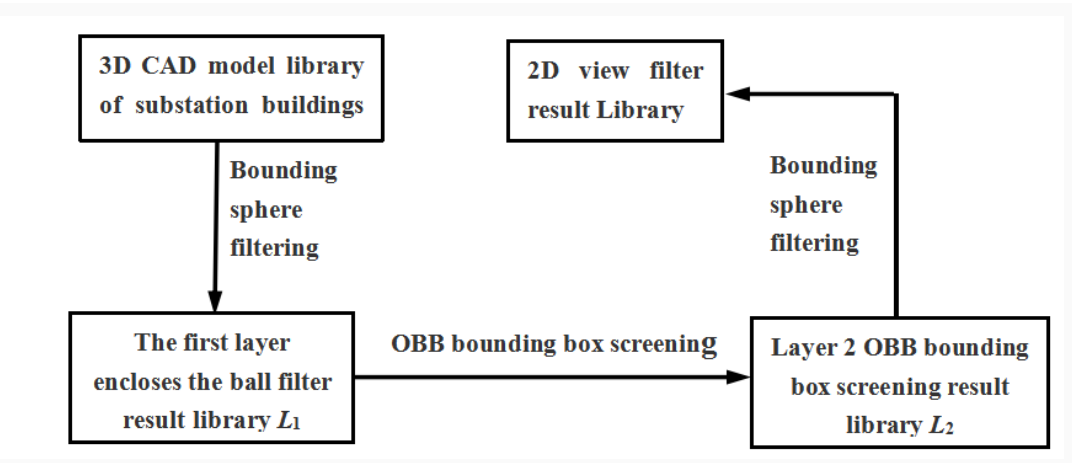
Figure 1. The 3D CAD model retrieval of transformer substation buildings based on point cloud data.